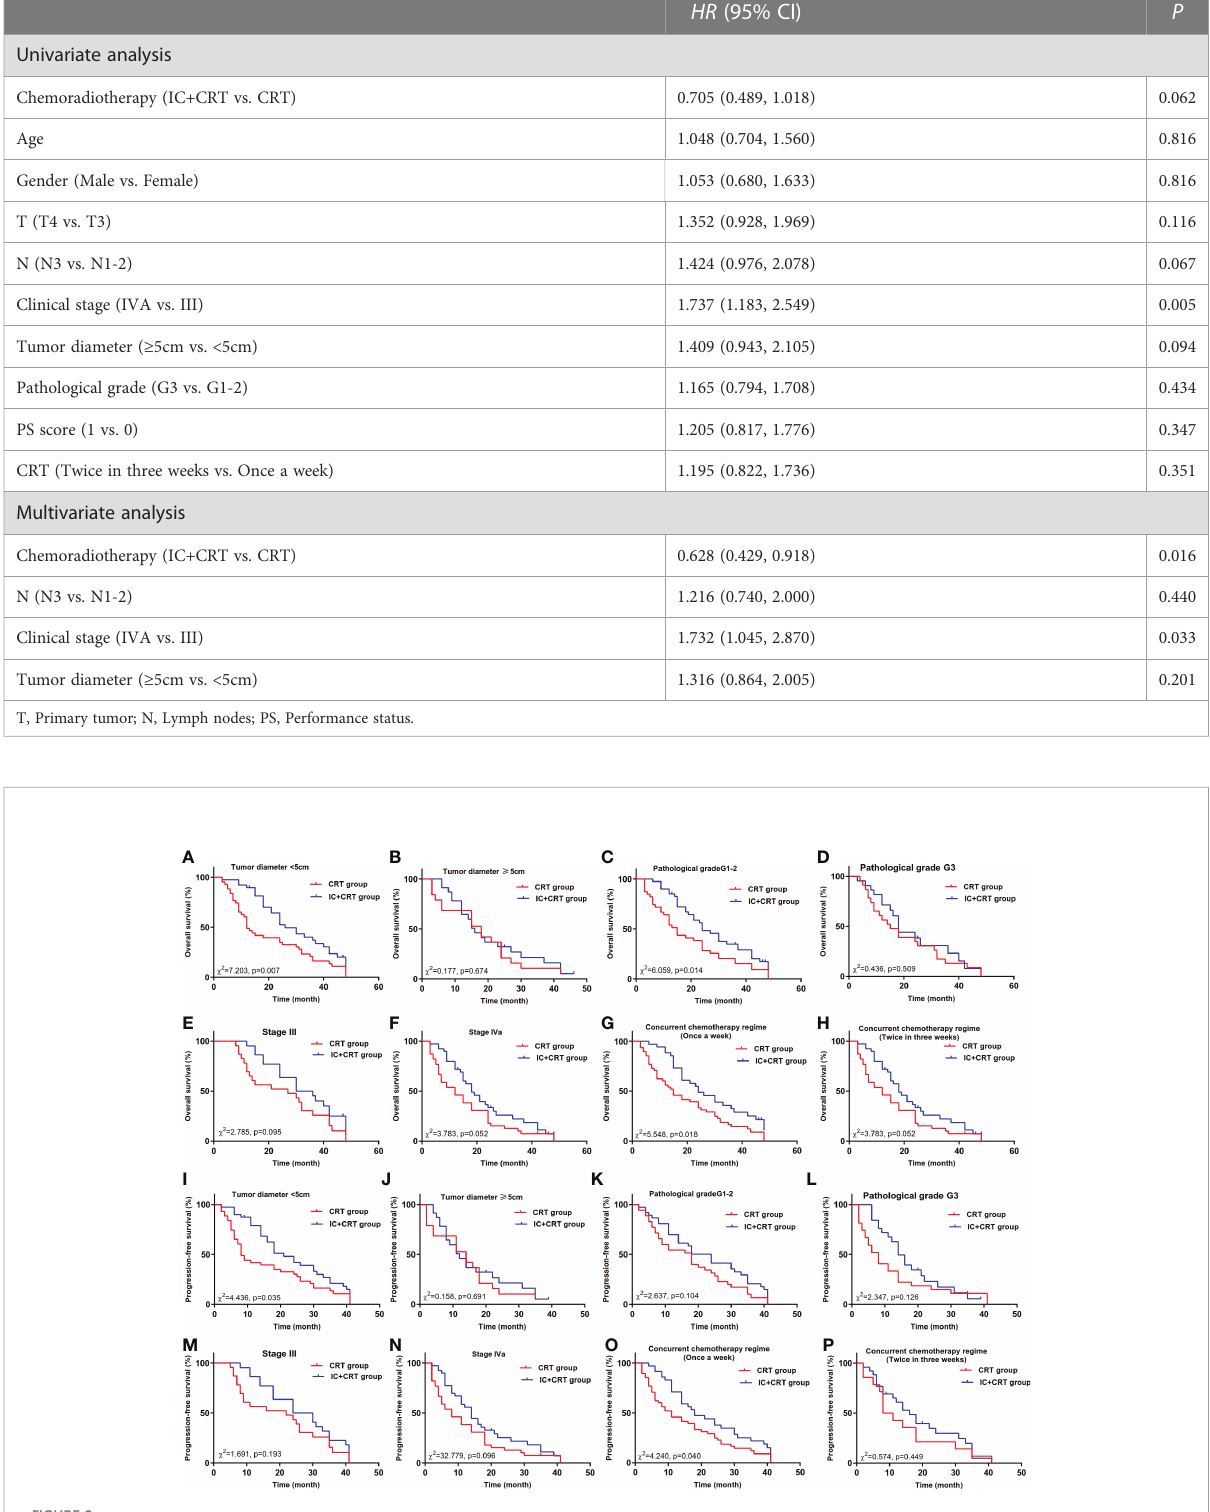
TABLE 4 Risk factors of Progression free survival.